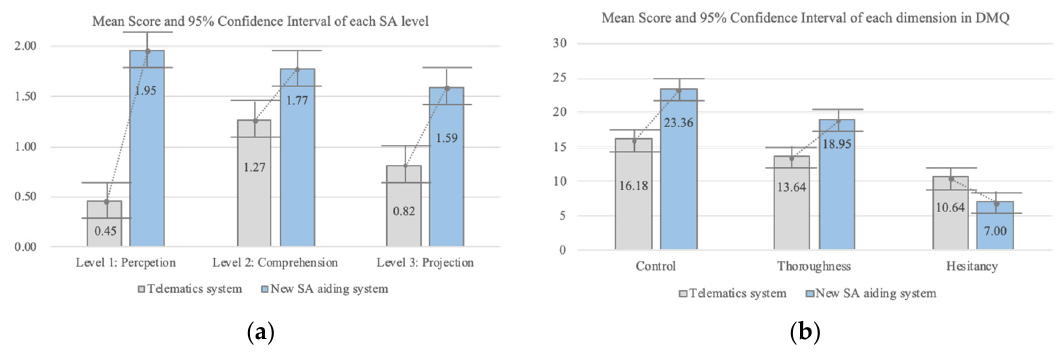
Figure 15. Mean Score and 95% Confidence Interval graph of SA and DMQ: ( a ) Mean score and 95% Confidence Interval of each SA level and ( b ) Mean score and 95% Confidence Interval of each dimension in DMQ (Source: Own creation).